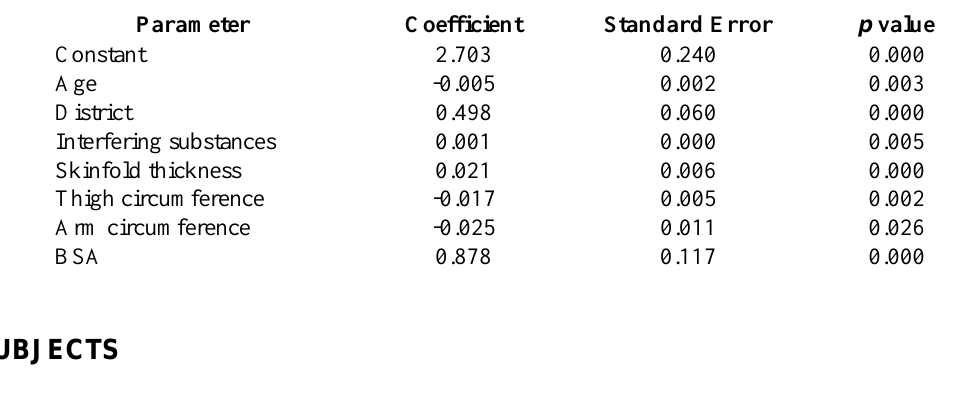
Best Model of Linear Regression Analysis Response: LN of Thyroid